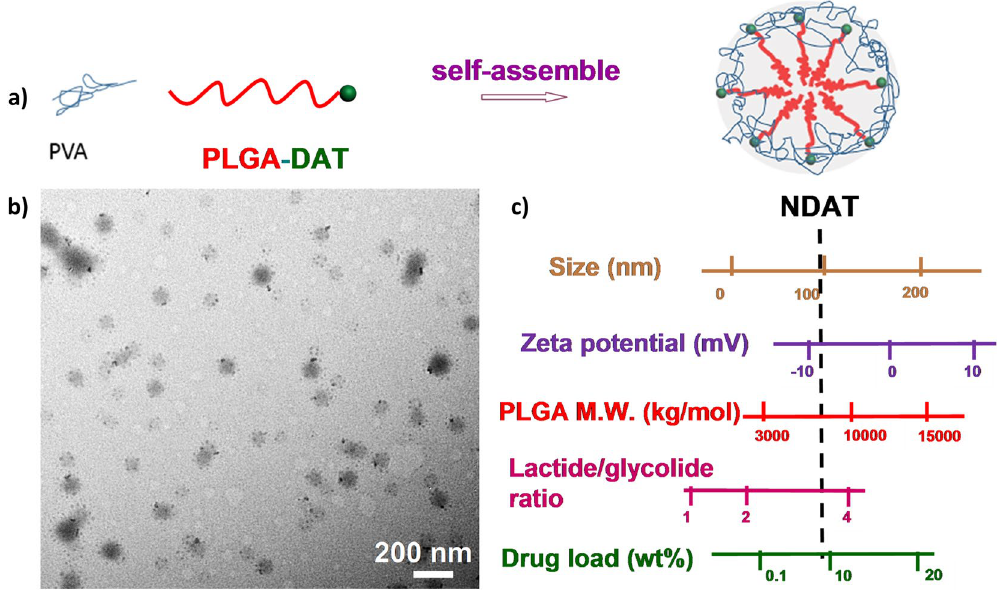
Figure 3. ( a ) Schematic illustrations of PLGA-DAT polymer self-assembled into NDAT. ( b ) TEM image of NDAT. ( c ) Results for NDAT (black dashed line) formulation parameters and physicochemical